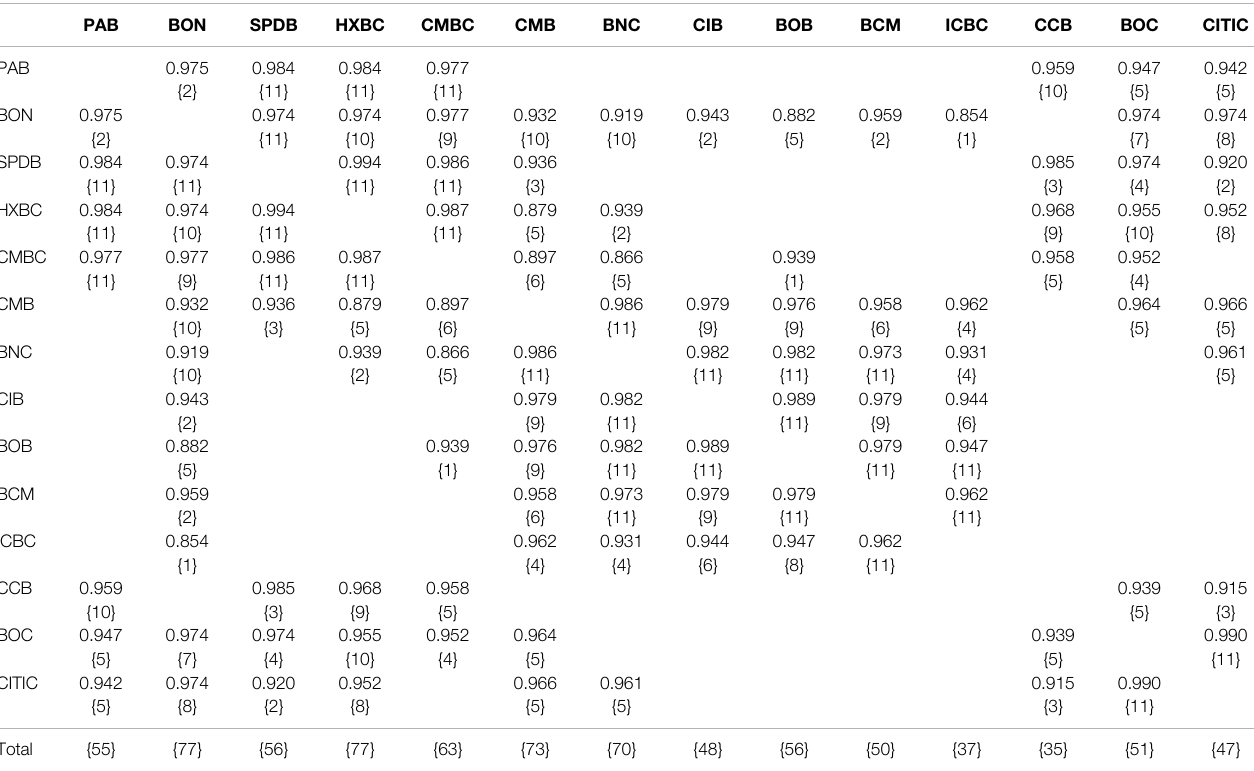
TABLE 5 | Statistics of related networks in various banking industries from 2008 to 2018.